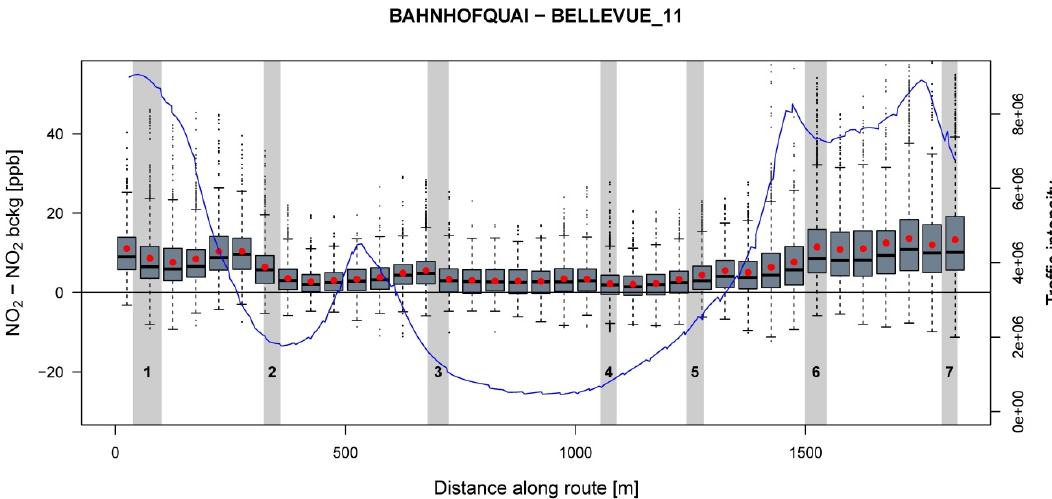
Figure 11. Estimated local emission signal (i.e., difference between measured NO 2 and background NO 2 ) between stations Bahnhofquai (1) and Bellevue (7) aggregated by 50m track length. The traffic intensity is indicated by the blue line.